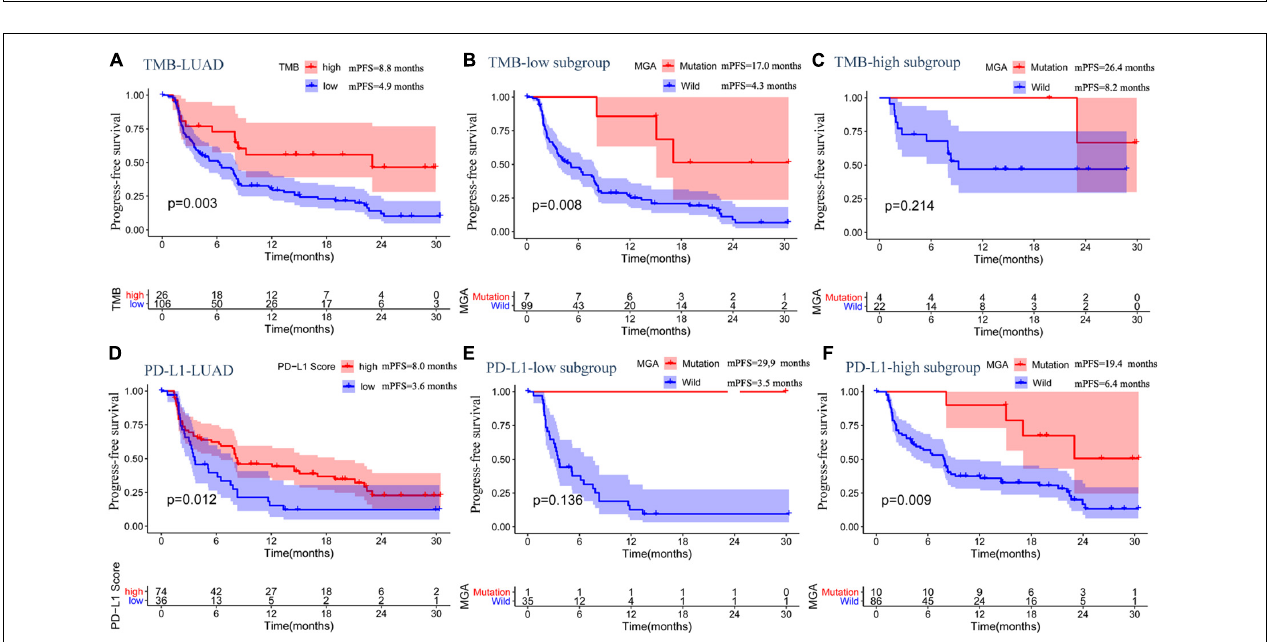
FIGURE 5 | The associations between MGA mutation and PFS in subgroup based on TMB score or PD-L1 expression in the pooled LUAD cohort. (A) Kaplan-Meier survival curves comparing PFS between the TMB-low and TMB-high group in the LUAD cohort. (B) Kaplan-Meier survival curves comparing PFS between the MGA mutant and wild-type group in the TMB-low subgroup. (C) Kaplan-Meier survival curves comparing PFS between the MGA mutant and wild-type group in TMB-high subgroup. (D) Kaplan-Meier survival curves comparing PFS between the PD-L1-low group and PD-L1-high group in the LUAD cohort. (E) Kaplan-Meier survival curves comparing PFS between the MGA mutant and wild-type group in the PD-L1-low expression score subgroup. (F) Kaplan-Meier survival curves comparing PFS between the MGA mutant and wild-type group in the PD-L1-high subgroup.